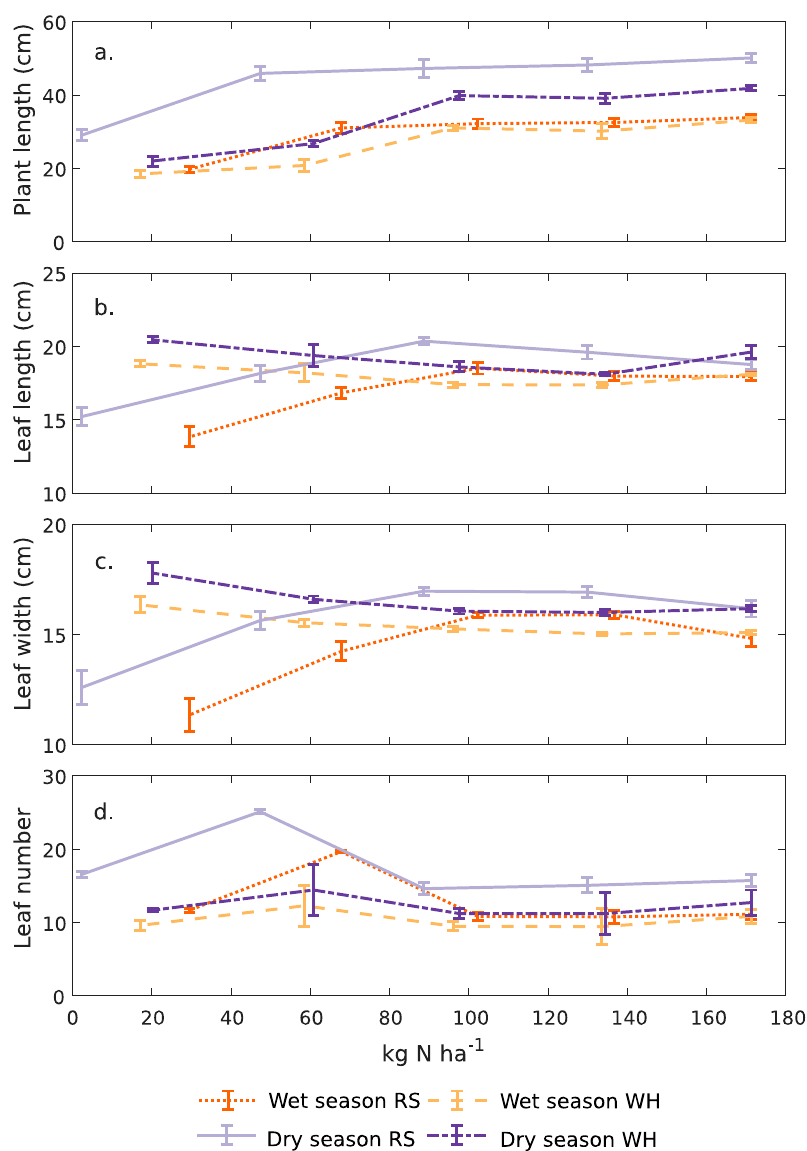
Figure 4. Plant traits as a function of total nitrogen input: ( a ) plant length, ( b ) leaf length, ( c ) leaf width, and ( d ) leaf number. Data were compared between each treatment (organic amendment made with rice straw (RS) or water hyacinth (WH)) and between growing seasons at 10 days after sowing. Vertical bars are standard errors ( n = 3).